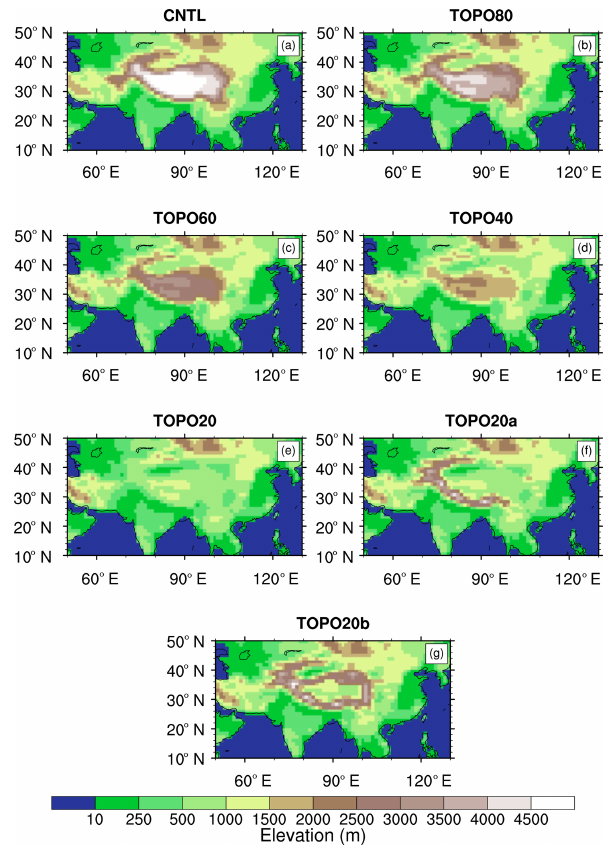
Figure 1. Surface elevations (m) prescribed in the ECHAM5 (a) CNTL, (b) TOPO80, (c) TOPO60, (d) TOPO40, (e) TOPO20, (f) TOPO20a, and (g) TOPO20b cases. Note that the CNTL sim- ulation includes modern elevations. The names of the other cases (e.g., TOPO60) indicate the surface elevation of the Himalayan– Tibetan region relative to the modern elevation (e.g., 60%). Cases TOPO2a and TOPO20b are modifications of the TOPO20 case (see Sect.